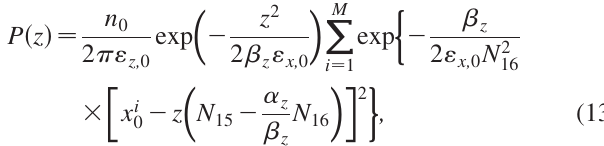
representing a series of Gaussian microbunches each of